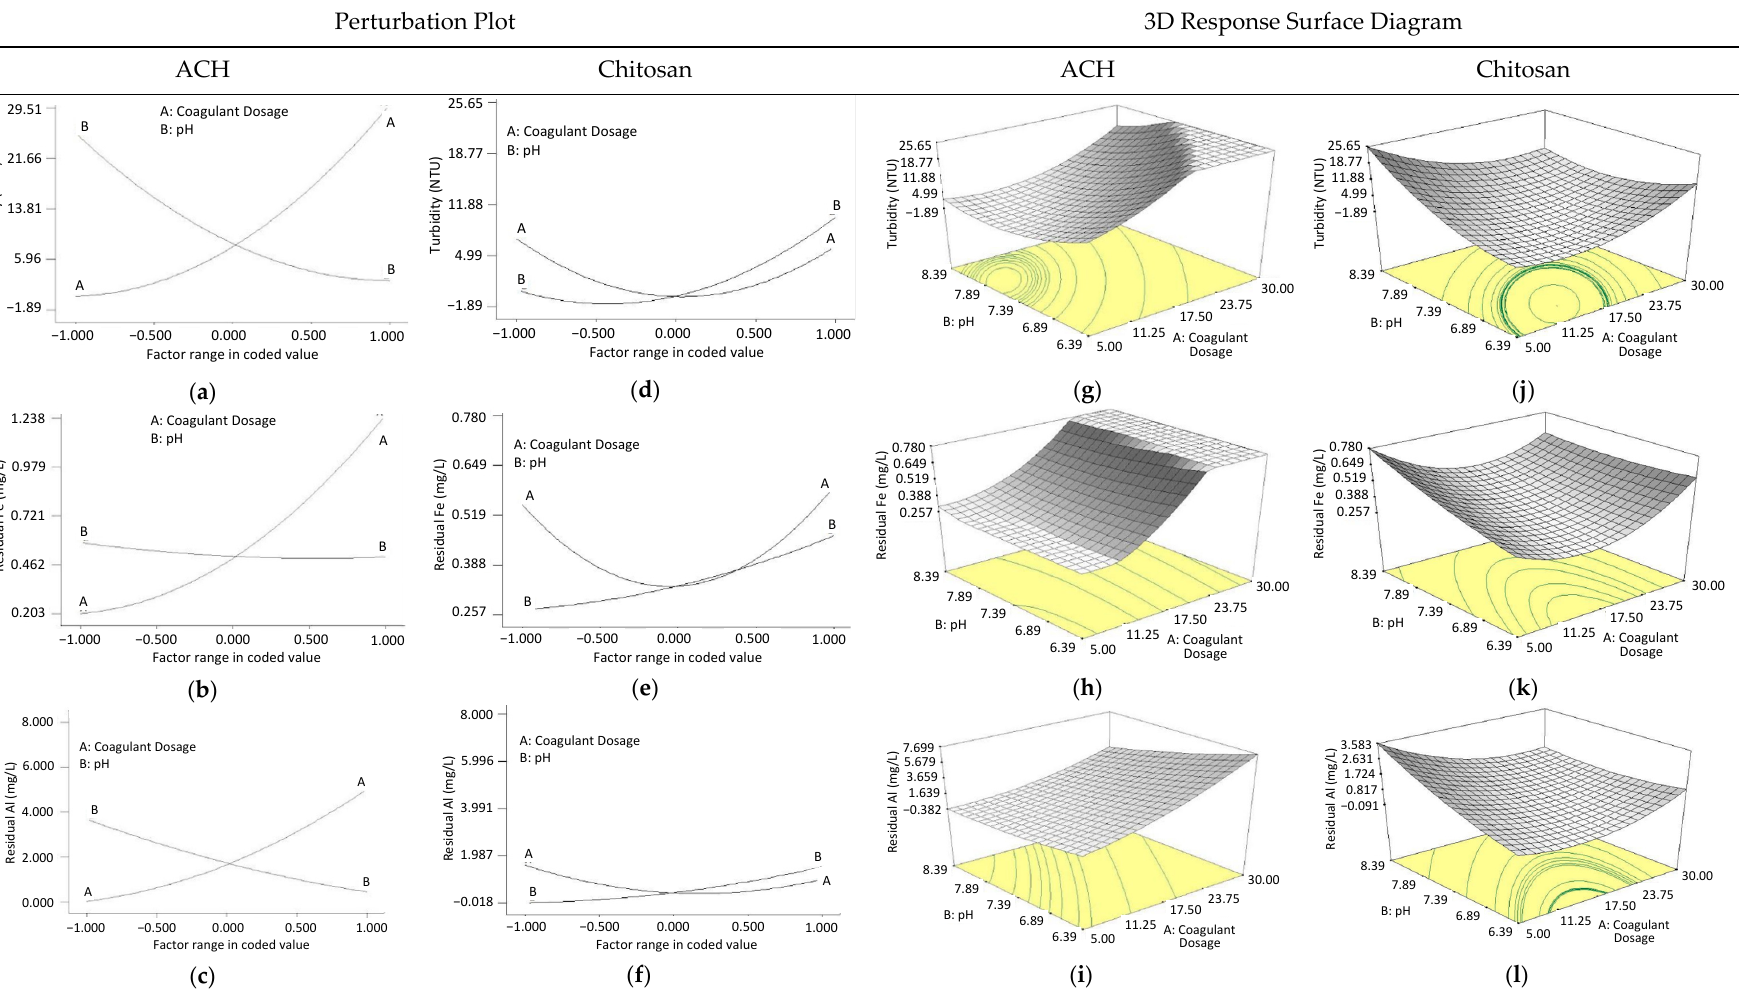
Figure 6. Perturbation plot ( a – f ), and 3-dimensional response surfaces diagram with contour plot ( g – l ); residual Fe, and residual Al concentration responses toward changes in coagulant dosage and pH using ACH and chitosan as coagulants.